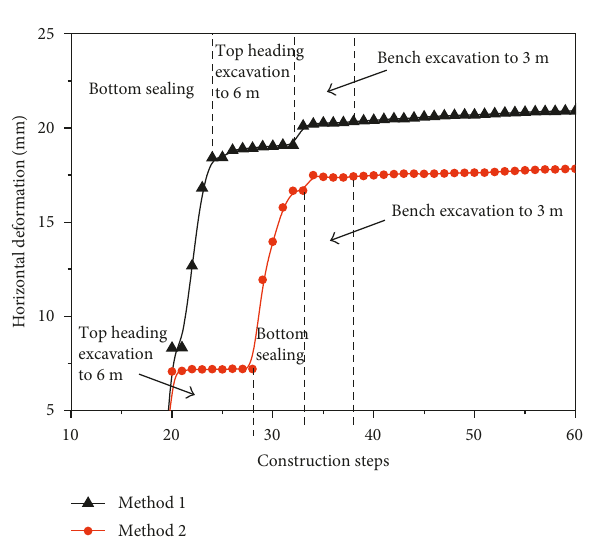
Figure 9: Horizontal deformation of shaft at different construction